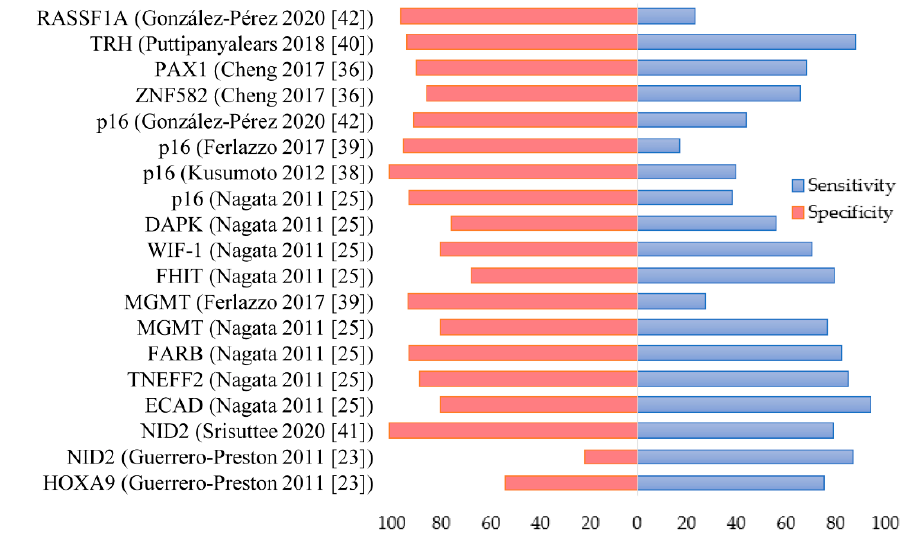
Figure 1. Reported sensitivities and specificities of DNA methylation biomarkers for the detection of oral